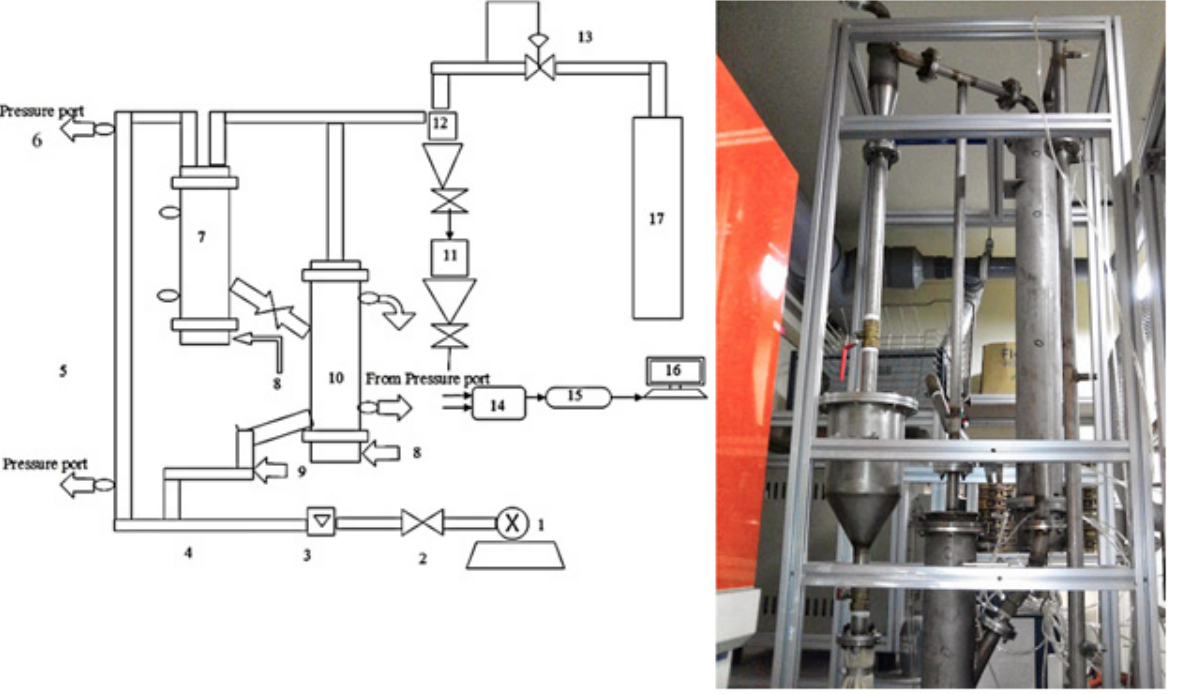
Figure 1. Pressurized circulating fluidized bed (CFB) system: 1. Compressor; 2. Valve; 3. Mass flow meter controller; 4. Riser inlet; 5. Riser; 6. Pressure port; 7. Upper bubbling bed; 8. Aeration; 9. L-valve and aeration; 10. Lower bubbling bed; 11.Hopper; 12. Cyclone; 13. Pressure controller including bag filters; 14. Pressure transducer; 15. Data logger; 16. Personal computer; 17. Final bag filter. Own elaboration based on [22].